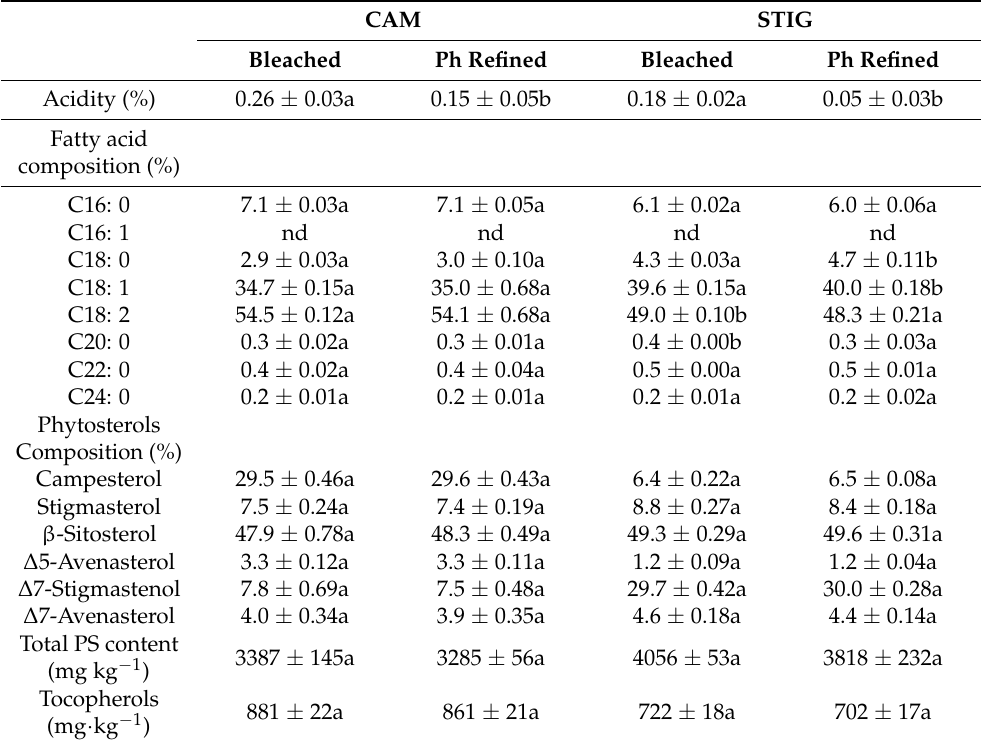
Table 4. Influence of the physical refining (PhR) process on fatty acid composition (%) and PS levels of the press oils of